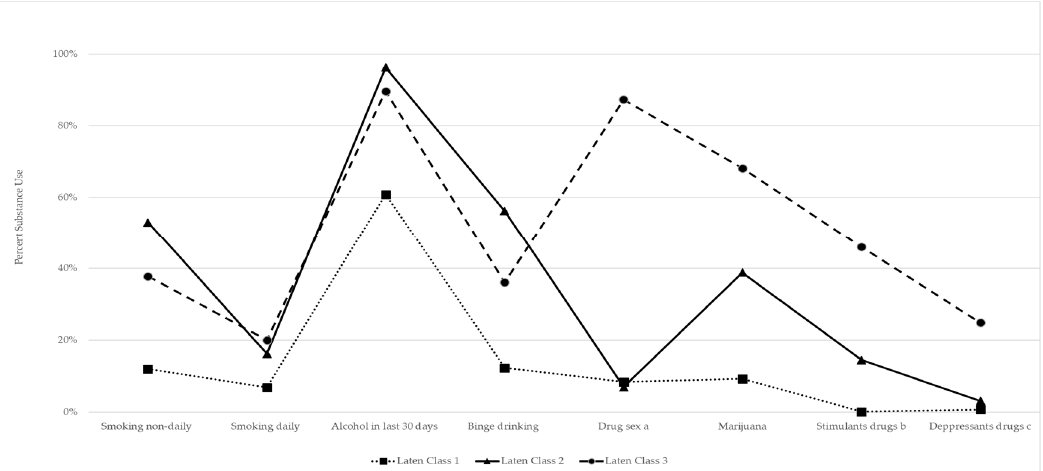
Figure 1. Patterns of smoking, alcohol, and drug use in MSM across three latent classes. Mexico City, 2018–2019. a. Includes methamphetamine (crystal meth), traumazol, erectile dysfunction drugs (EDDs), and volatile nitrates (poppers). b. Includes cocaine, crack, ketamine, amphetamines. c. Includes benzodiazepines, rivotril, Ghb, opioids, inhalable. Class 1. The first group was identified as low substance use, accounting for 49.0% of participants, and characterized by current alcohol use (59.9%).